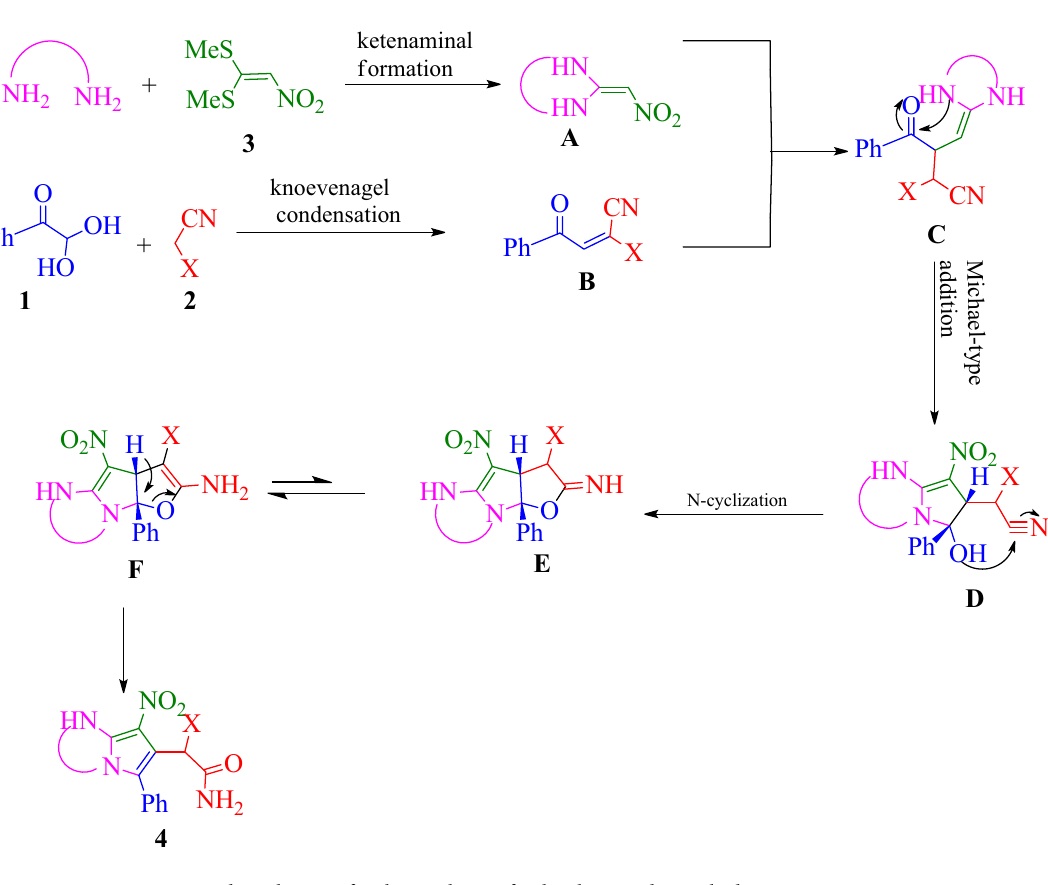
Figure 5. Proposed mechanism for the synthesis of polysubstituted pyrrole